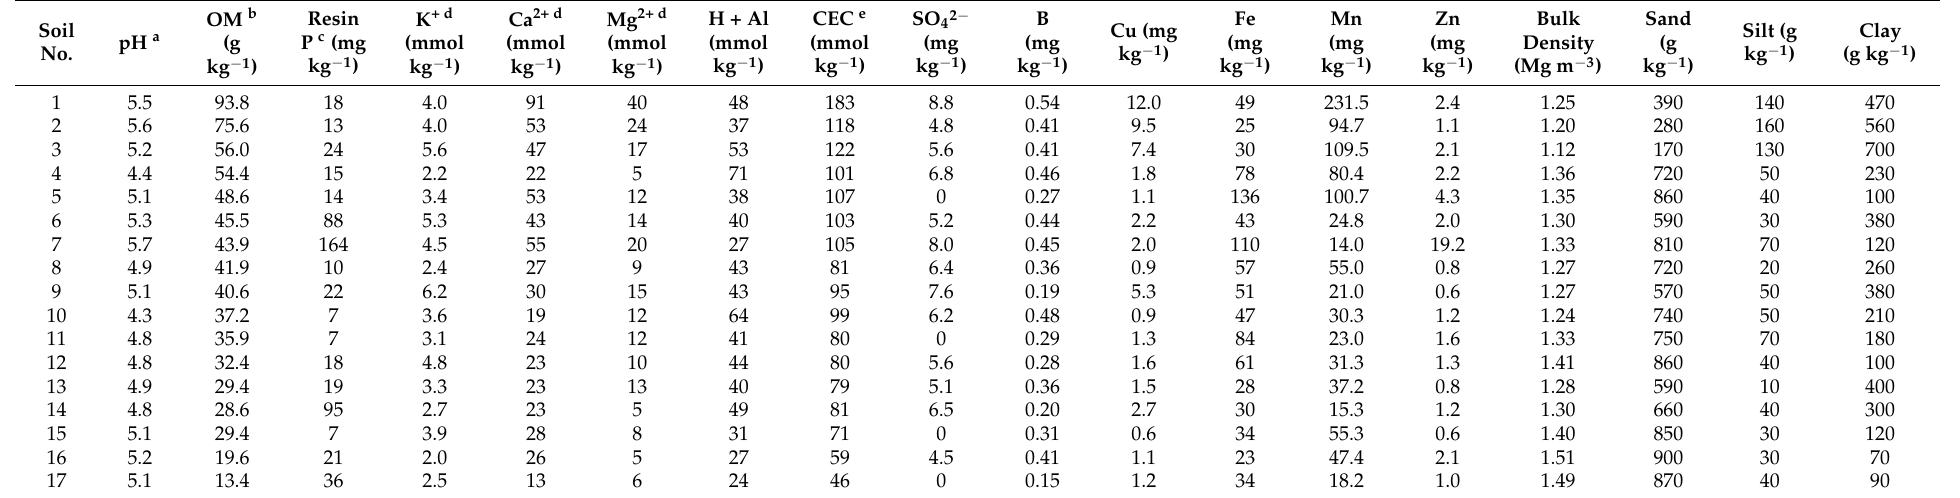
Table 2. Physicochemical properties and fertility parameters for soils